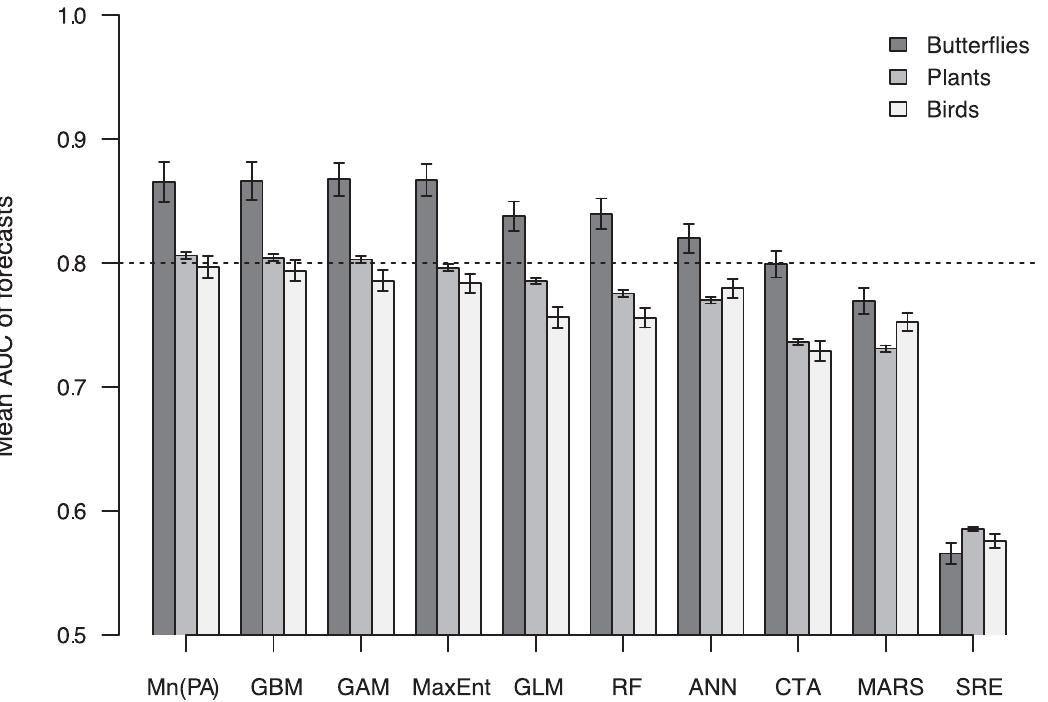
Figure 1. Accuracy of model forecasts. The accuracy of forecasts generated by each modelling framework was measured by mean AUC and reported for each major taxonomic group. Error bars represent 6 1 standard error of the mean. The dashed line indicates the rule-of-thumb for good predictions (AUC=0.8). Abbreviations: ANN = artificial neural networks, CTA = classification tree analysis, GAM = generalised additive models, GBM = generalised boosted models, GLM = generalised linear models, MARS = Multivariate adaptive regression splines, MaxEnt = maximum entropy models, Mn(PA) = prediction mean from all presence-absence modelling frameworks, RF = random forests, SRE = surface range envelopes.